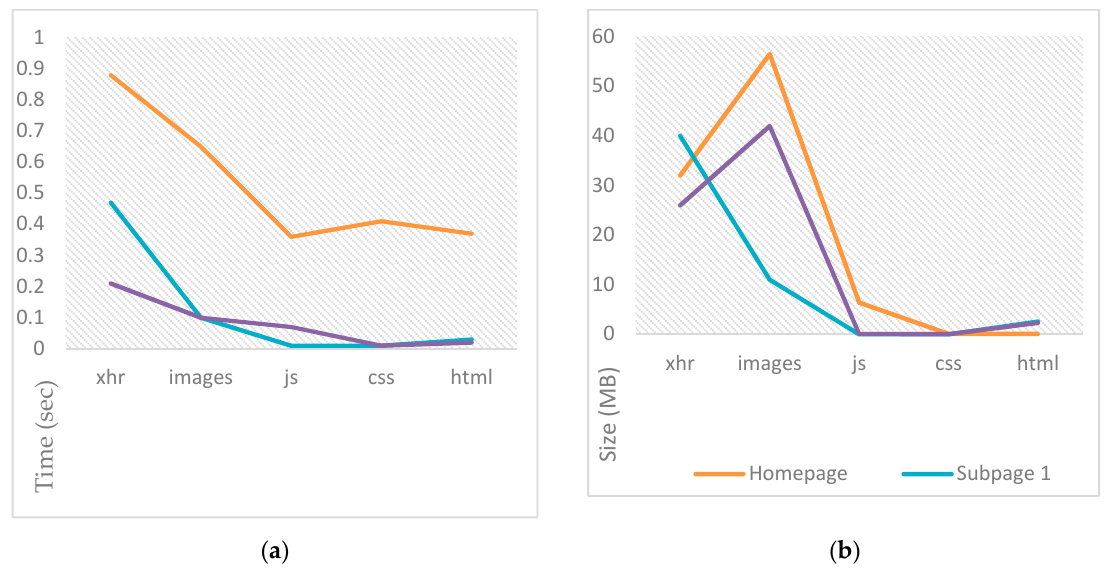
Figure 15. Cashed content used normally for each page of the platform: ( a ) Resources loading time (sec) ( b ) Size of data transferred (MB).